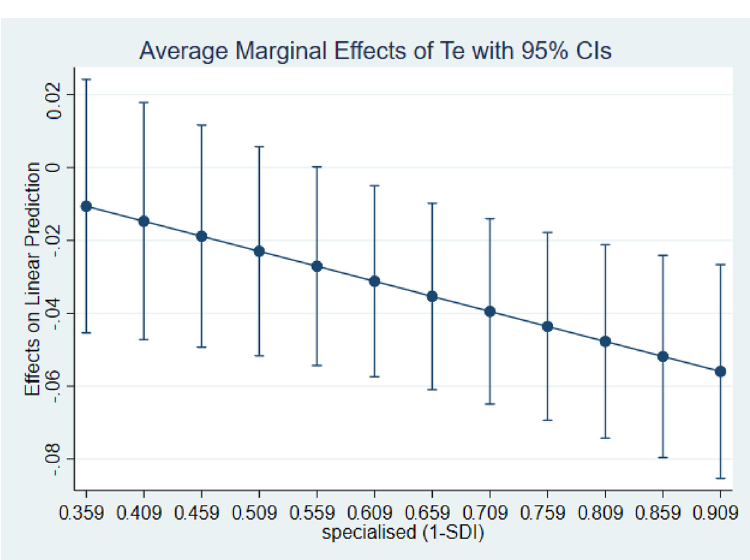
Figure 3. Marginal effect of accumulated temperature on technical ef fi